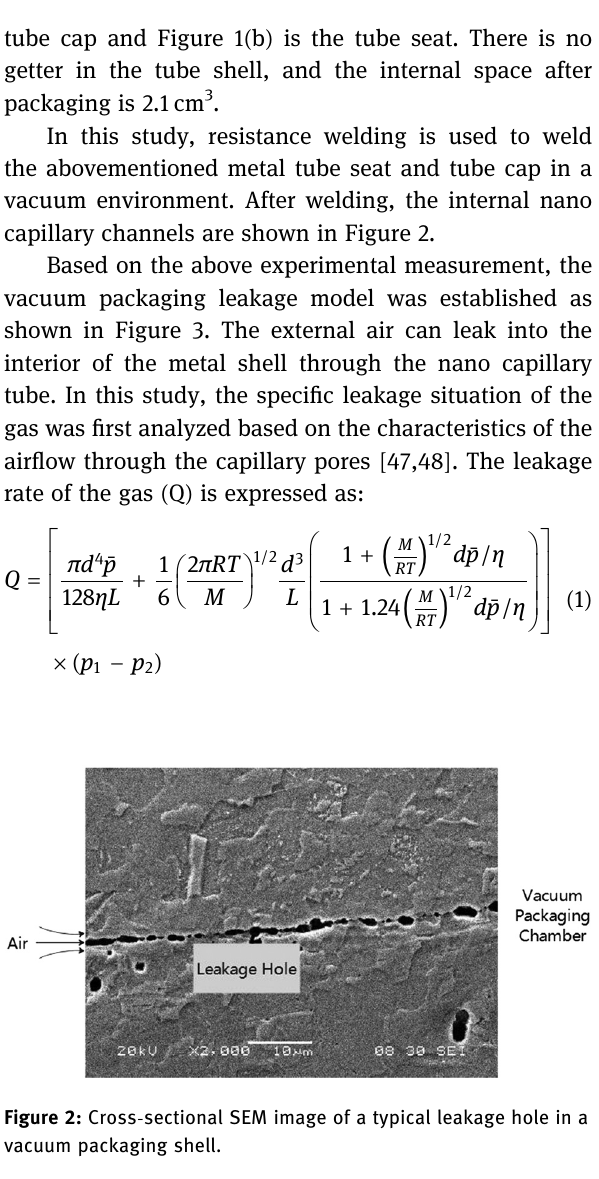
Figure 1: MD2A tube cap ( a ) and tube seat ( b ) .